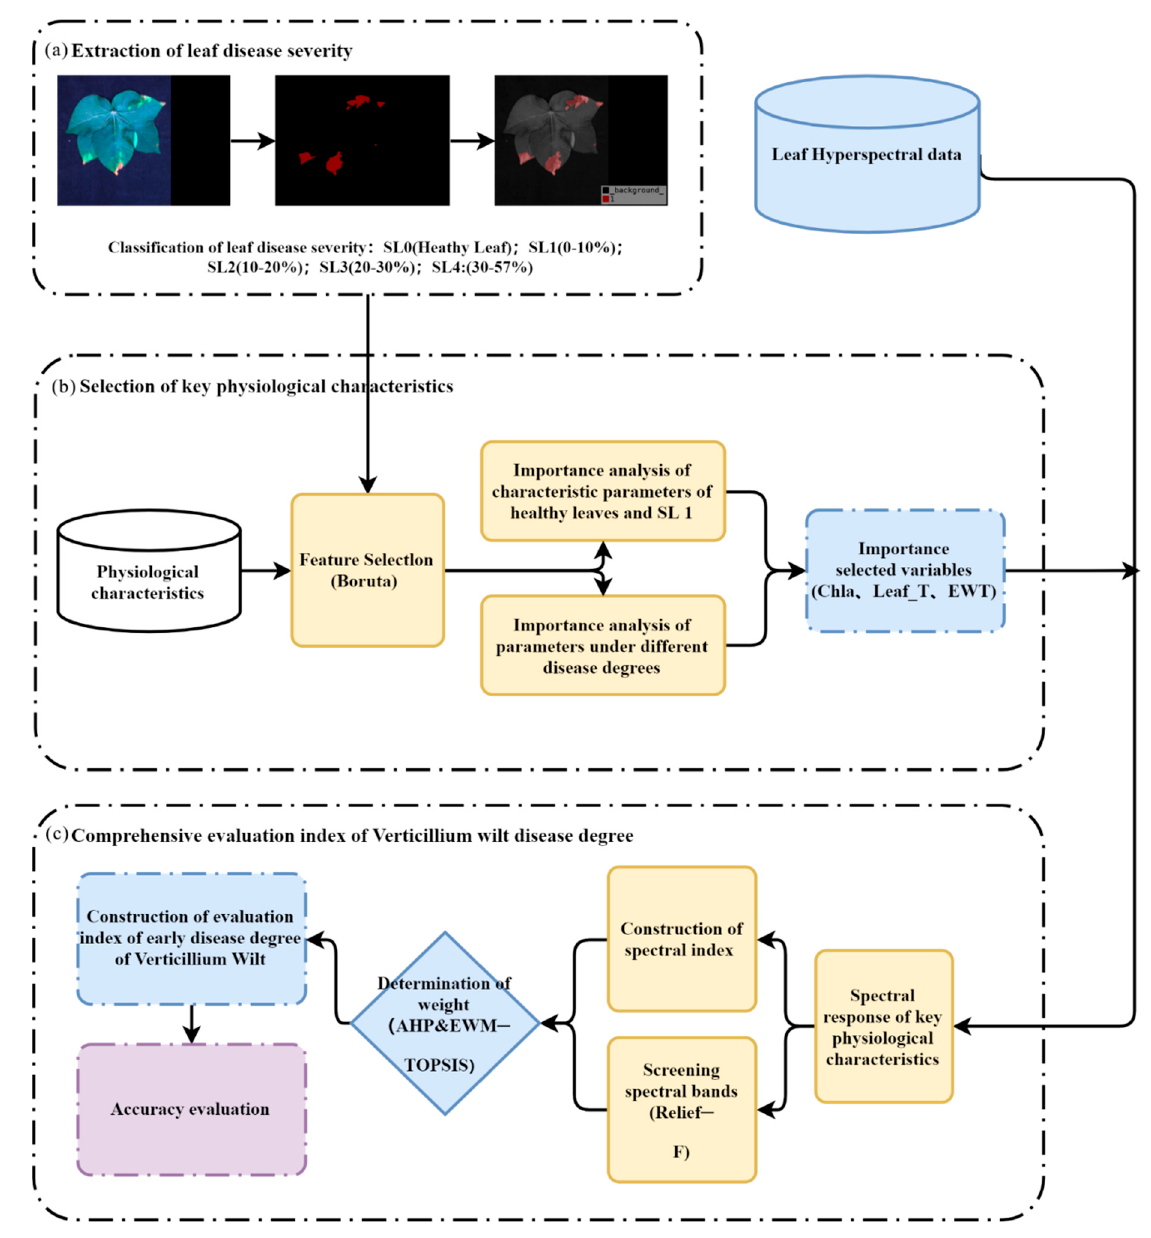
Figure 2. Flow chart for the development of early monitoring indicators for VW disease in cotton based on the fusion of hyperspectral indices and multi-physiological traits. ( a ) Extraction of leaf disease severity, ( b ) selection of key physiological characteristics, ( c ) comprehensive evaluation index of verticillium wilt disease degree.